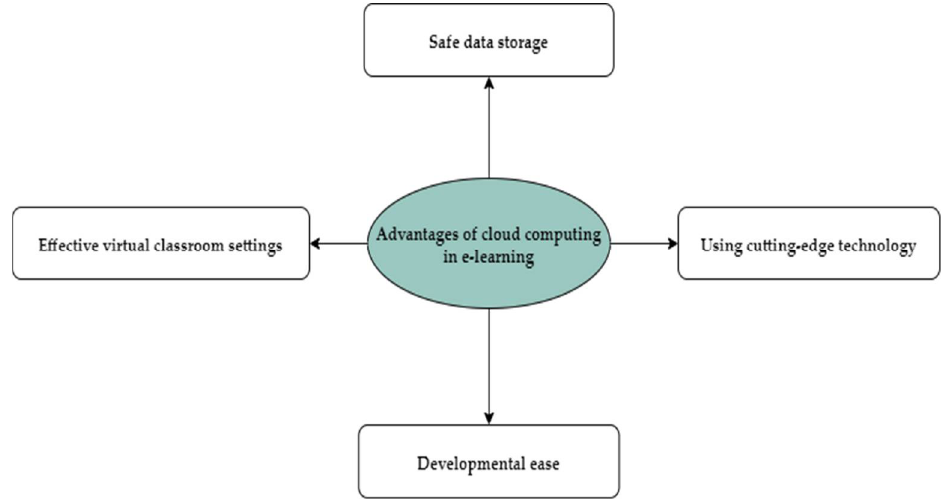
Figure 2. Advantages of using cloud computing in e-learning. Source: The Authors.